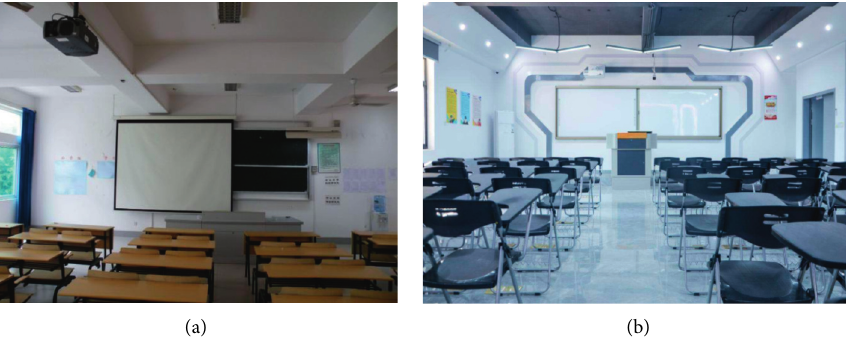
Figure 1: Comparison between traditional teaching and immersive virtual teaching. (a) Traditional teaching scene. (b) Immersive virtual teaching